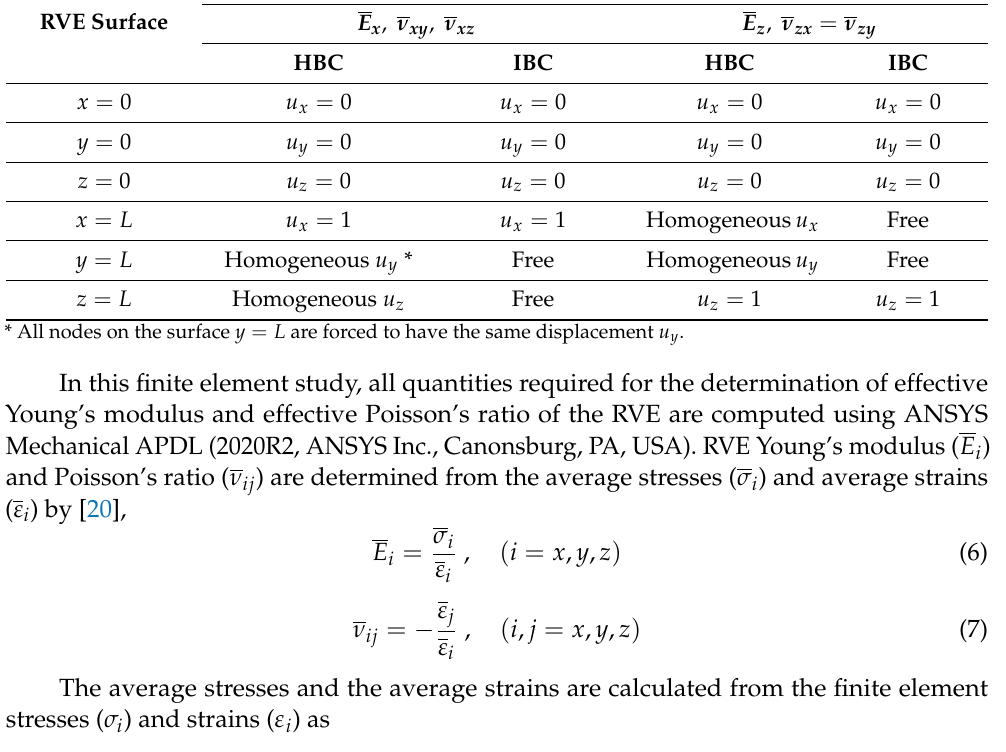
Table 2. RVE boundary conditions for the characterization of effective